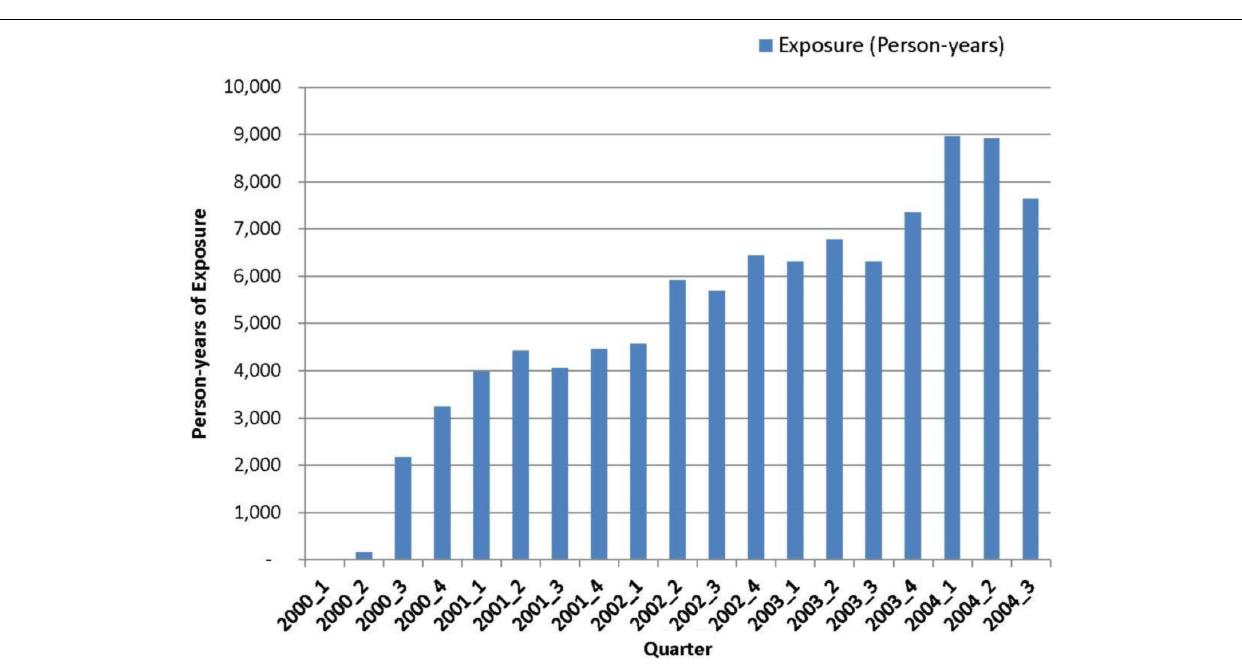
FIGURE 2 | Rofecoxib exposure (person-years) cumulated over time in the EU-ADR database